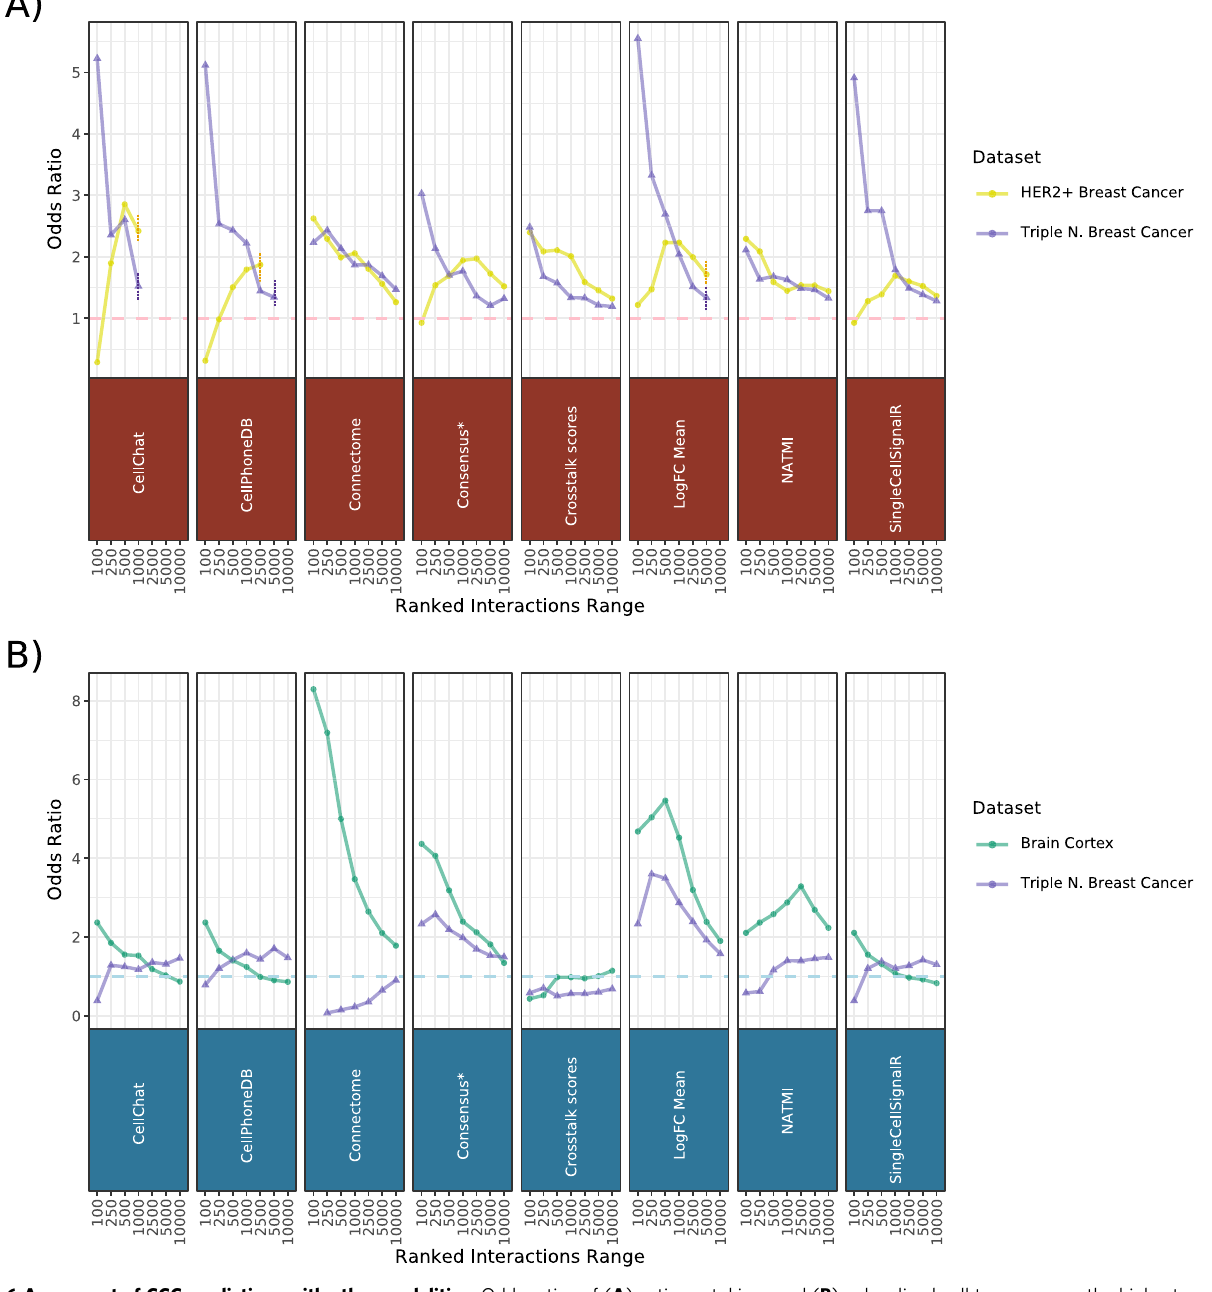
Fig. 6 Agreement of CCC predictions with other modalities. Odds ratios of ( A ) active cytokines and ( B ) colocalized cell types among the highest ranked interaction predictions, across a ranked range between 100 and 10,000. Odds ratios representing the association of preferentially ranked CCC predictions and ( A ) cytokine activities and ( B ) spatial adjacencies were calculated using Fisher ’ s exact test. Asterisk (*): Consensus represents the aggregated ranks of all interactions predicted by all the methods. Dashed horizontal line is the baseline represented by an odds ratio of 1. The dashed vertical lines represent the truncated ranges of CellChat, CellPhoneDB, and LogFC Mean, arising from their relatively stricter preprocessing steps. Source data are provided as a Source Data fi